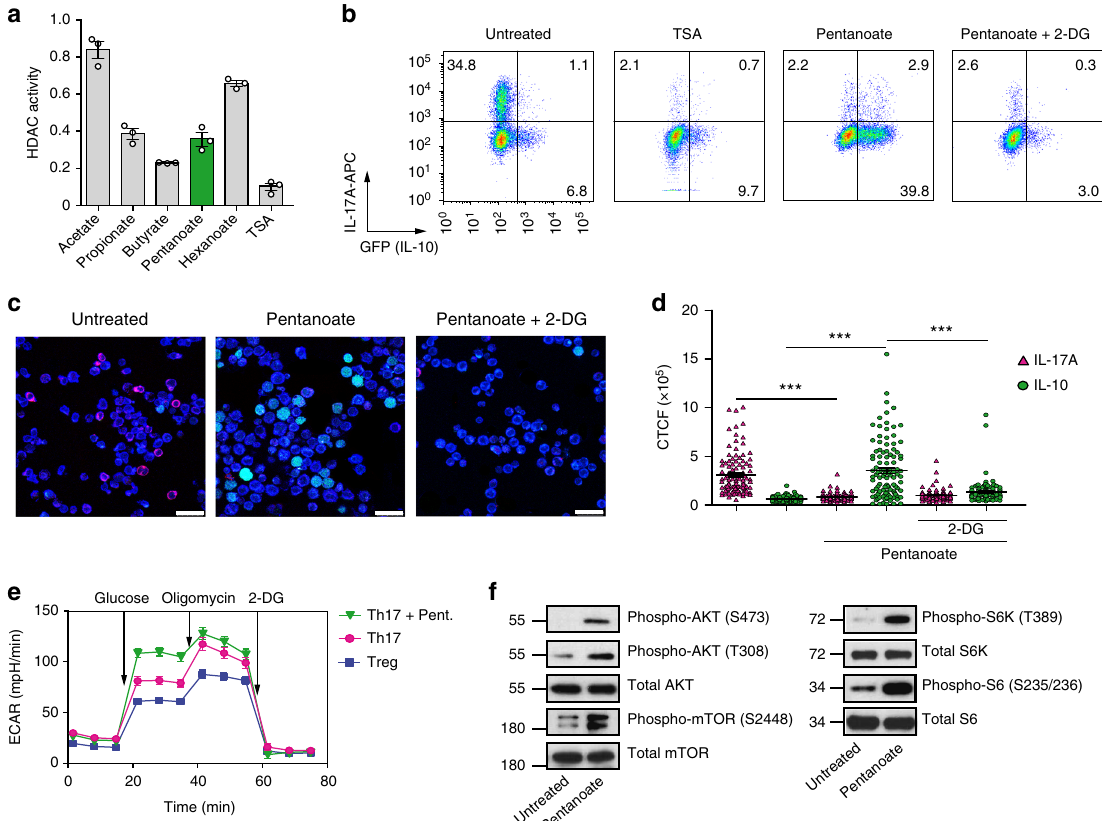
Fig. 2 Pentanoate induces IL-10 expression in Th17 cells. a Bar graphs show the HDAC activity in whole cell lysates obtained from murine CD4 + T cells treated with SCFAs (5 mM) or TSA (500 nM). The HDAC activity of untreated CD4 + T cells is arbitrary set to 1 ( n = 3). b – d CD4 + T cells isolated from FIR x tiger mice were polarized under Th17-inducing conditions and treated with TSA (10 nM), pentanoate (5 mM) or pentanoate + 2-DG (2 mM). Cells were analyzed by fl ow cytometry ( b ) and fl uorescence microscopy ( c , d , scale bar = 25 micron) for CD4 (blue), IL-17A (red) and GFP (green) expression on day 4 of the cell culture. For counting of cytokine-positive cells, the CTCF method was used as described in Methods. *** P < 0.001 (Student's t -test). e CD4 + T cells isolated from spleens and LNs were polarized under Th17- or Treg-inducing conditions for 3 days. A representative ECAR measurement of Th17 cells polarized in the presence and absence of pentanoate is shown (Tregs served as control cells). Three independent experiments were performed. f Detection of the main components of the AKT/mTOR signaling pathway by immunoblotting of Th17 cell lysates after treatment with pentanoate. Three similar experiments were